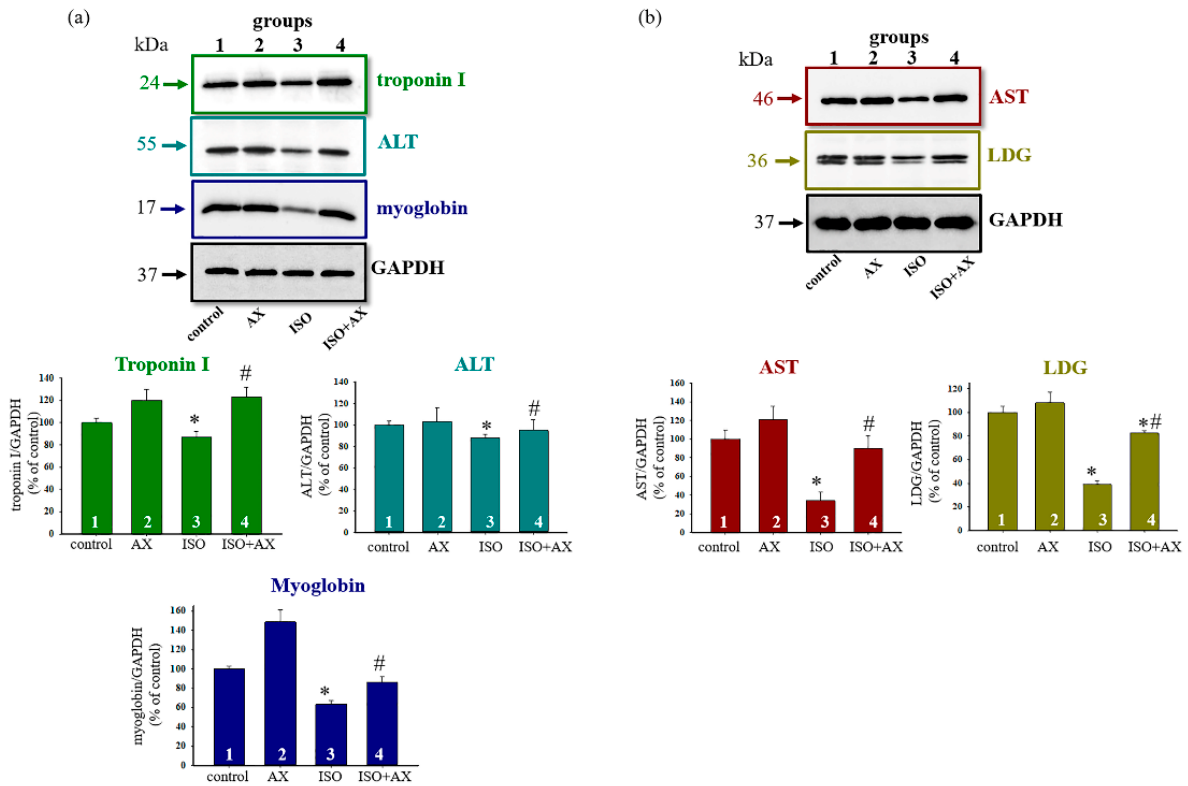
Figure 1. Effects of the administration of AX and injection of ISO on the content of Troponin I, ALT, Myoglobin, AST, and LDG in rat heart tissue. Protein samples were extracted and subjected to Western blotting. The immunodetection of GAPDH was used as a loading control. ( a )—Immunostaining with Troponin I, ALT, Myoglobin antibodies and GAPDH (upper part); quantification of immunostaining by computer-assisted densitometry presents as a ratio of proteins to GAPDH (low part), ( b )—Immunostaining with AST and LDG antibodies and GAPDH (upper part); quantification of immunostaining by computer-assisted densitometry presented as a ratio of proteins to GAPDH (low part). Bar graphs represent the levels of appropriate proteins; the data are presented as the means ± SD of three independent experiments. * p < 0.05 significant difference in the protein level in comparison with the control (group 1). # p < 0.05 compared to RHM isolated from ISO-injected rats (group 3). The statistical significance of the differences between the pairs of mean values was evaluated using the Student-Newman-Keul test.